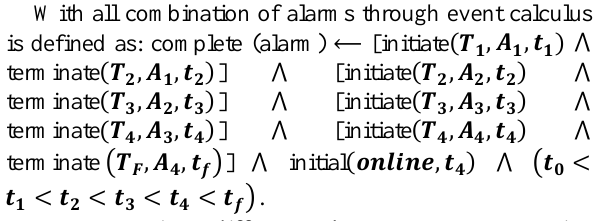
The flow of DAGSVM mechanism is formulated in mathematical interpretation for establish the inter-related